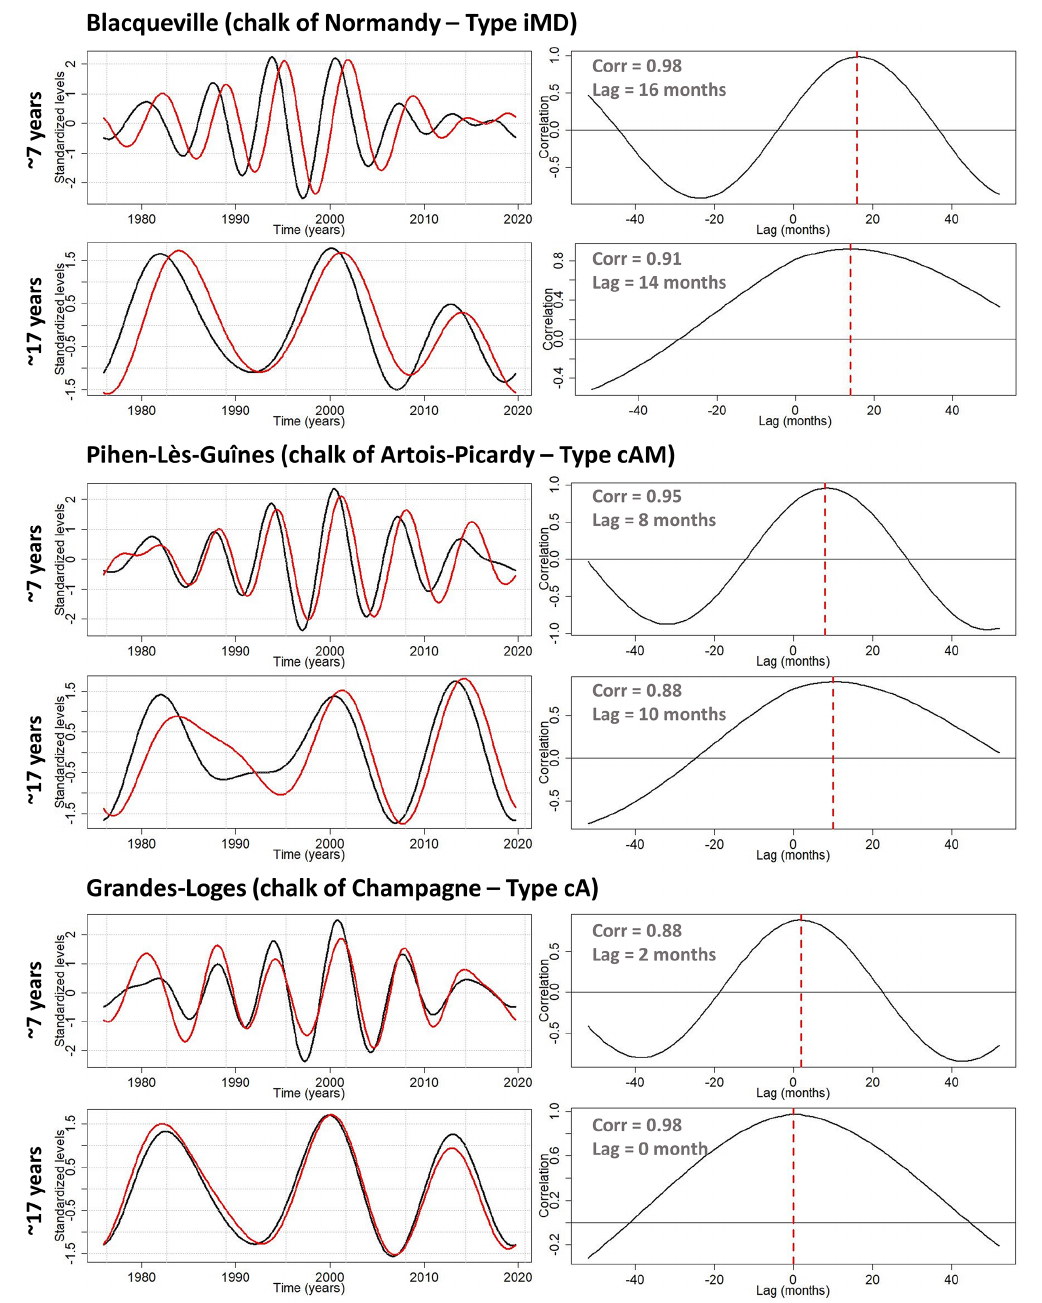
Figure 15. Multi-annual ( ∼ 7-year – MAV) and decadal ( ∼ 17-year – DV) components of effective precipitation (black) and groundwater levels (red) in chalk aquifers of the Paris Basin (left side). Cross-correlation between MAV and DV components of effective precipitation and groundwater levels (right